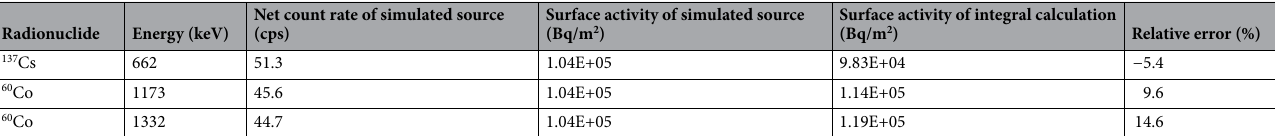
Table 10. Comparison of surface source experiment results with Monte Carlo simulation detection efficiency